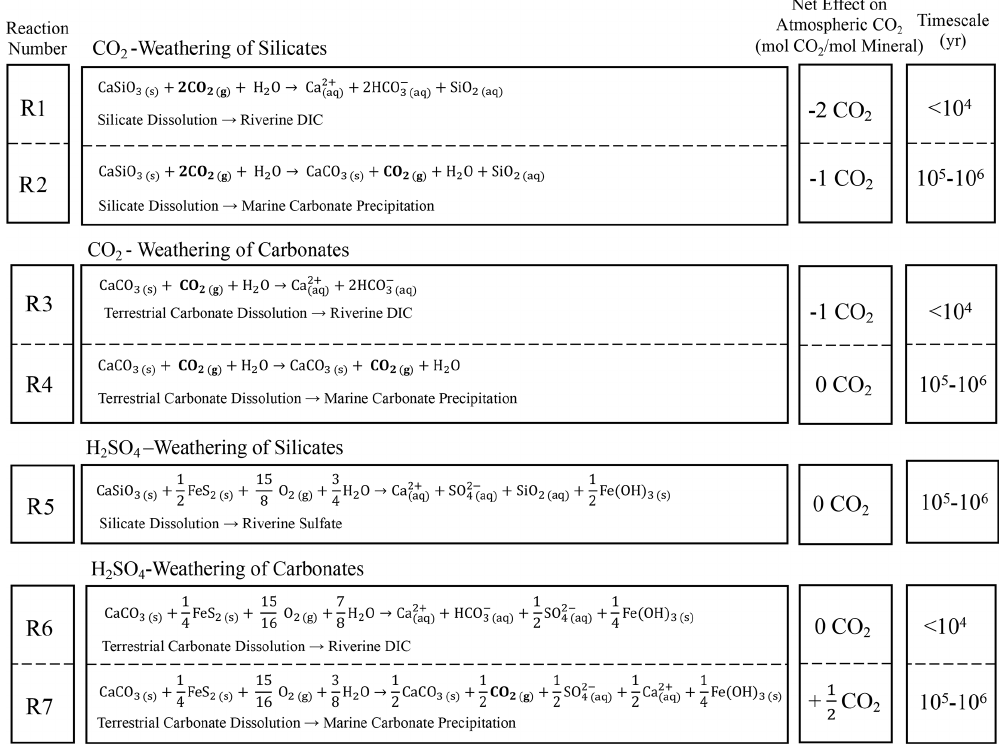
Figure 1. Schematic summarizing the reactions, timescales, and net CO 2 release to or uptake from the atmosphere accompanying weathering of silicate and carbonate minerals. Uptake or release depends upon timescale, as shown, and as discussed in the text. CaSiO 3 is used as a generic silicate